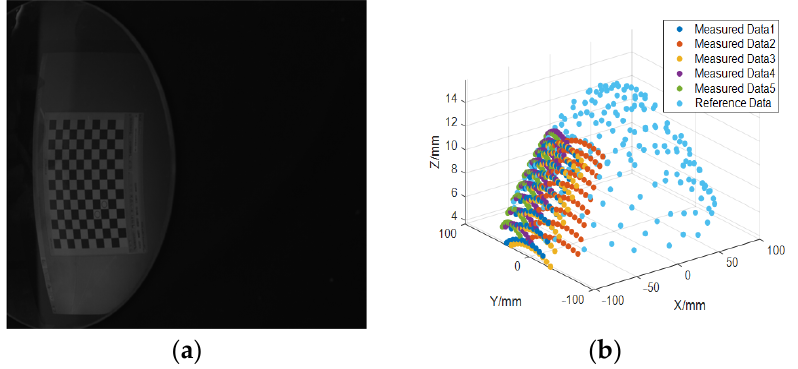
Figure 10. Restoration of spherical mirror feature points. ( a ) Mirrored checkerboard image of the spherical mirror at position 5. ( b ) Display of feature points and reference data.